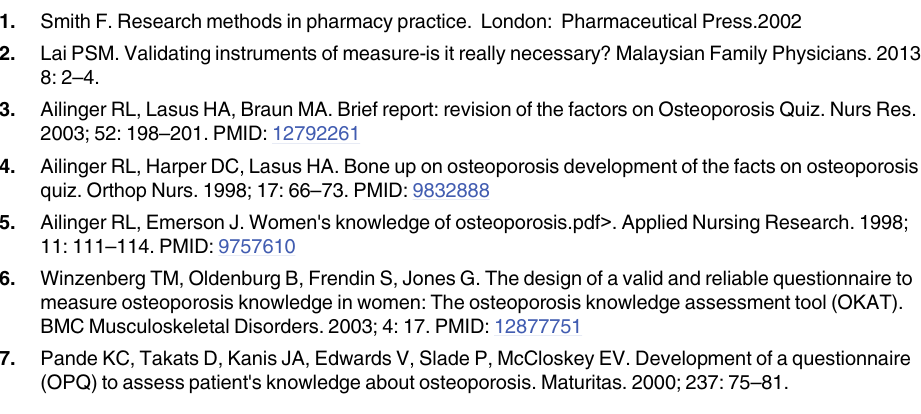
S1 Table. Sample of the Osteoporosis Prevention and Awareness